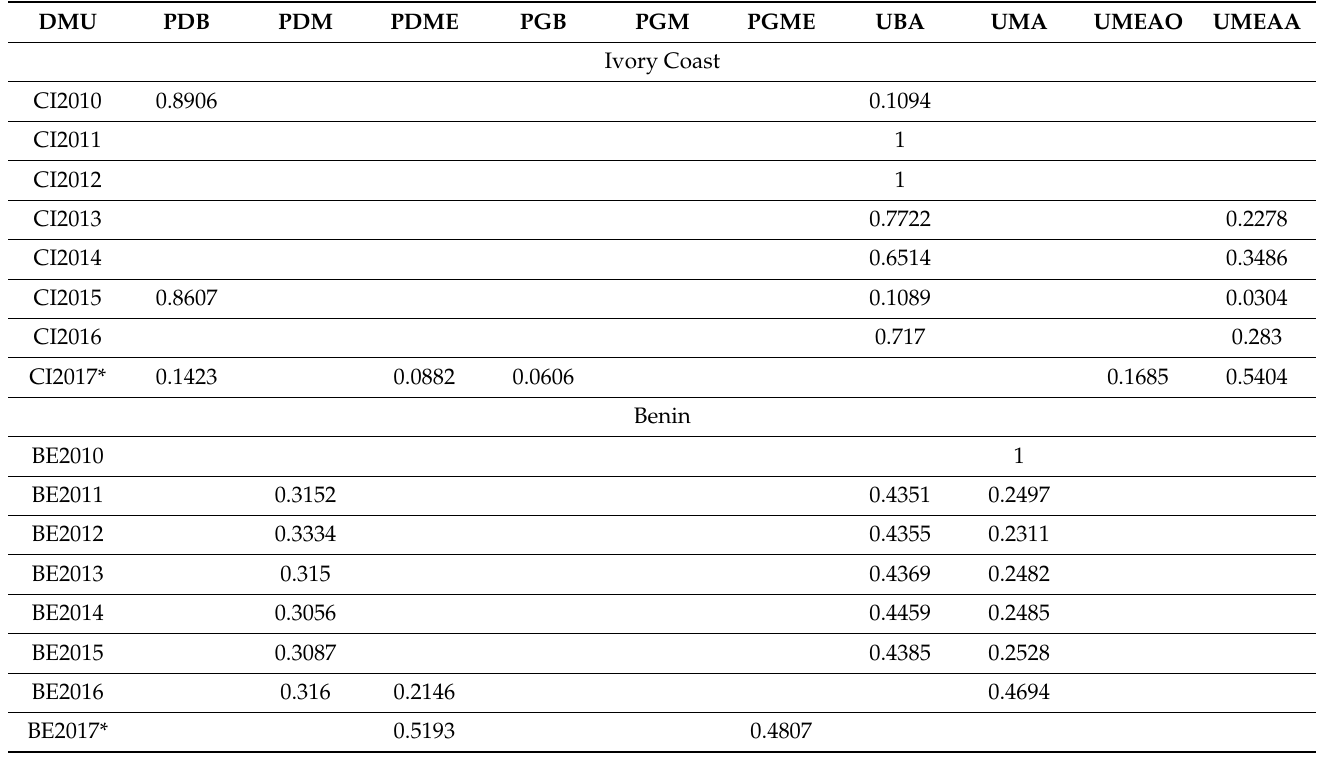
Table 16. DEA self-evaluation optimal weight by